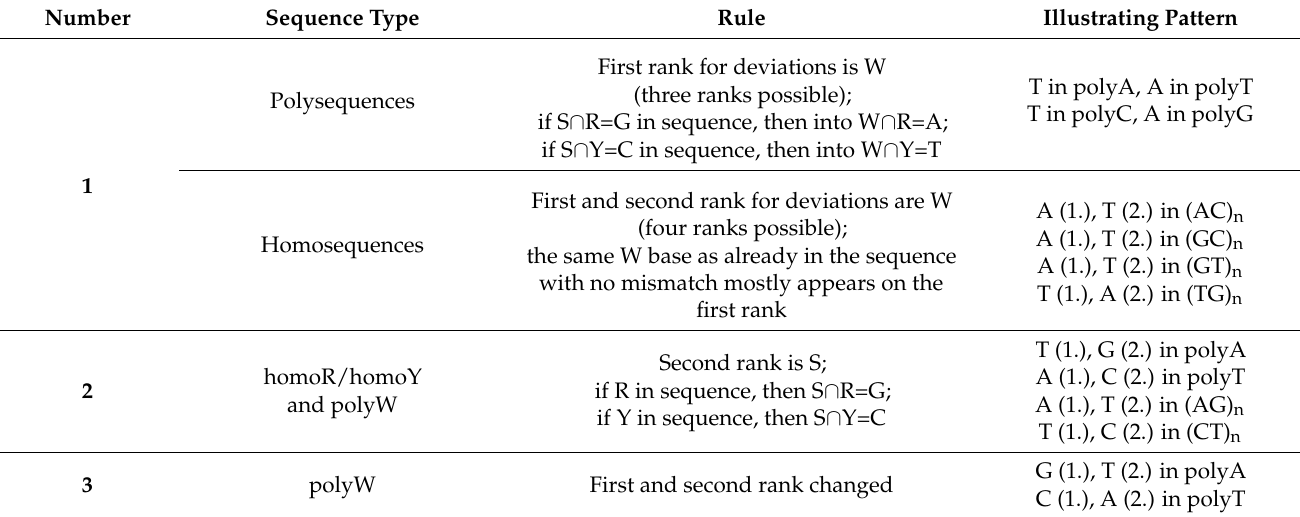
Table 7. Rules and general observations in the deviation patterns of tandem repeats with b = 1 and b = 2 in introns and intergenic regions. The descriptions of how the subsets of sequences behave are provided. polyW is either polyA or polyT, polyS is either polyC or polyG and all other sequences are tandem repeats with a repeat unit length of b = 2 with W = {A;T}, S = {C;G}, R = {A;G}, Y = {C;T}, K = {G;T} and M = {A;C}. To regenerate deviation patterns observed, rules 1 to 3 have to be applied in this order to sequences with no